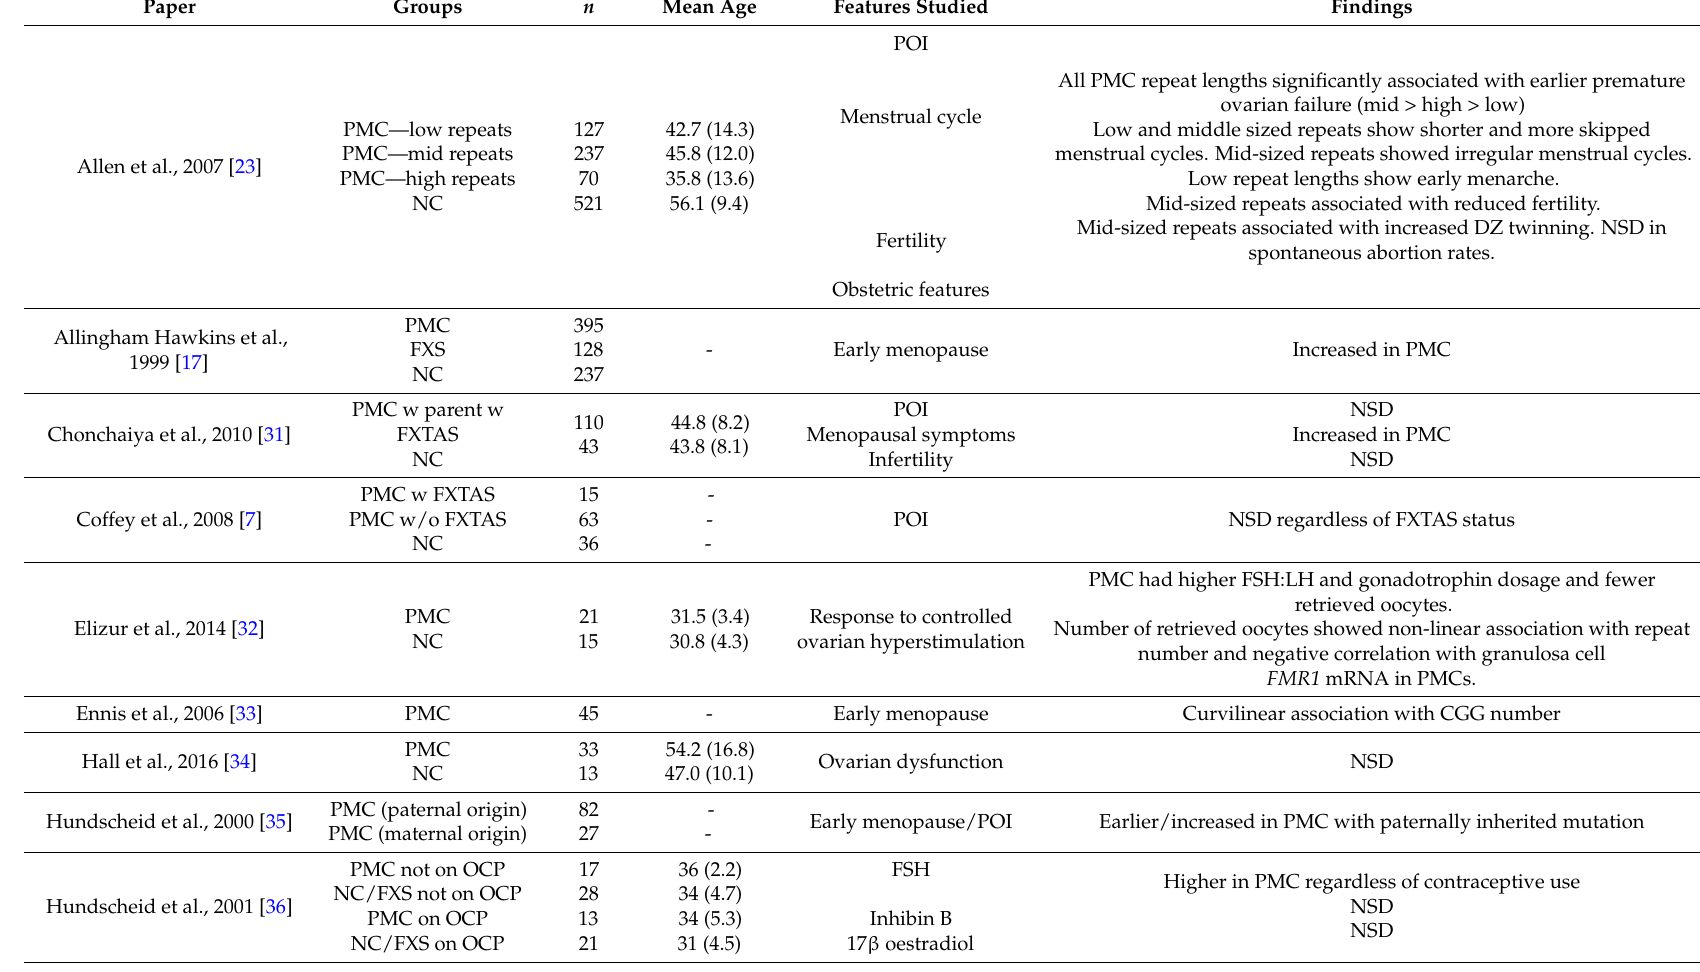
Table 1. Summary of studies considering reproductive health in female premutation carriers